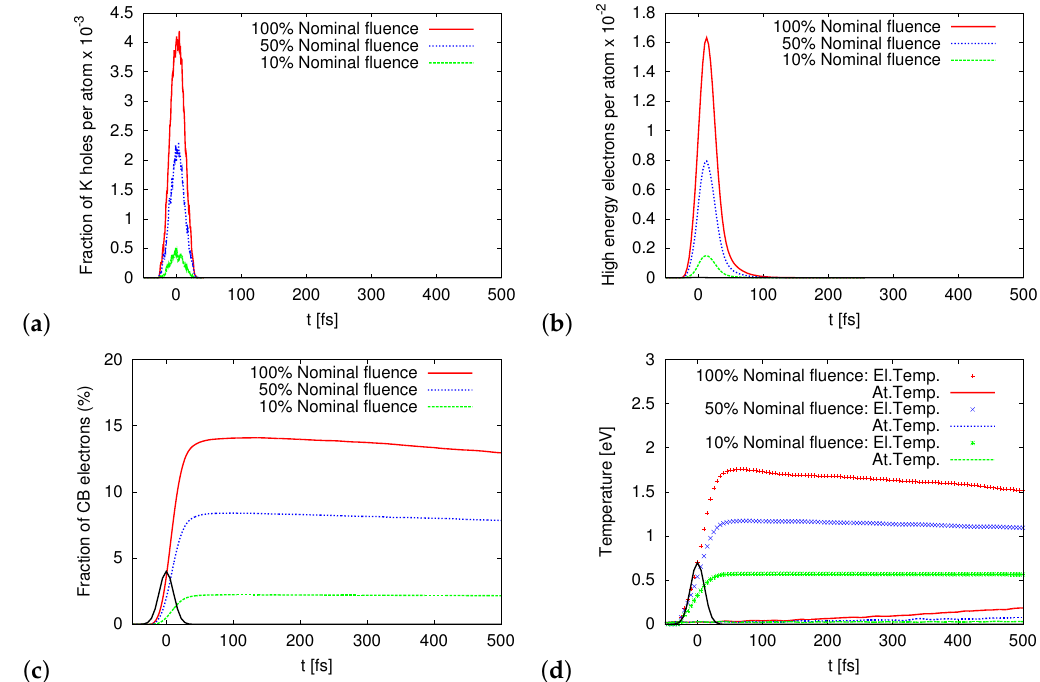
Figure 1. Theoretical predictions for: ( a ) Fraction of K-shell holes per atom, ( b ) fraction of non-thermalized energetic electrons excited per atom, ( c ) fraction of thermalized electrons in the bottom of the conduction band per atom, and ( d ) tem- peratures of thermalized electrons and ions in silicon crystal after irradiation with an X-ray pulse of 5.95 keV photon energy, duration of 25 fs FWHM, at the absorbed doses of 2.70 eV/atom, 1.35 eV/atom, and 0.27 eV/atom. These correspond to 100%, 50%, and 10% of the nominal peak fluence, respectively. The FEL pump pulse temporal shape is schematically represented by a black solid line. Time zero corresponds to the maximum of the pump